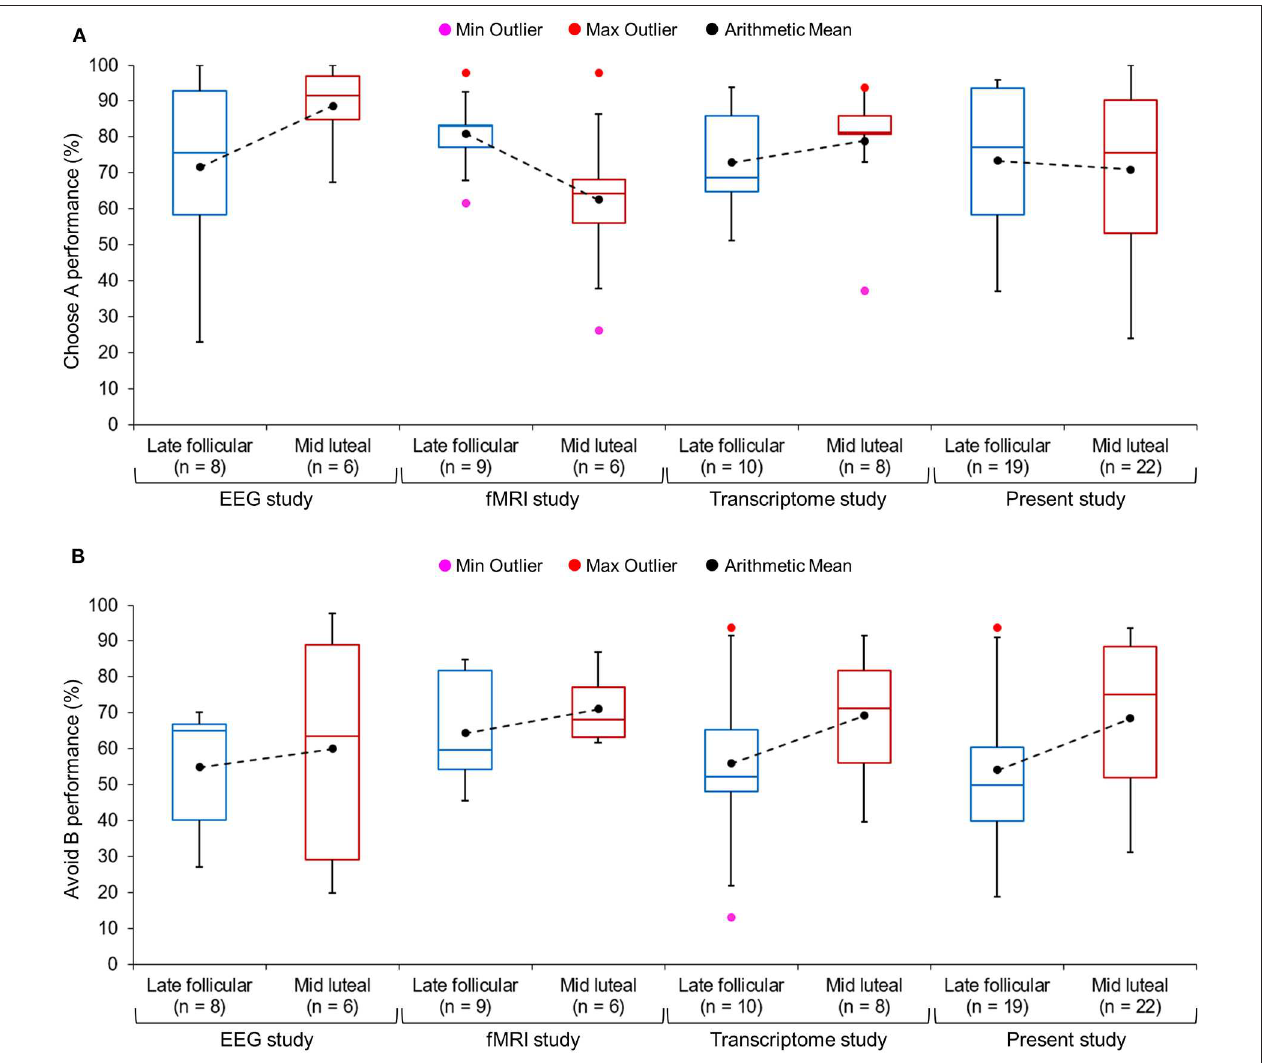
FIGURE 3 | Boxplots of the percentage of (A) correct choice of the best stimulus A, and of (B) correct avoidance of the worst stimulus B in novel stimulus pairs presented during the transfer phase. The ends of the whisker are set at 1.5*interquartile-range above the third quartile and 1.5*interquartile-range below the first quartile. Only the minimum (Min Outlier) and maximum (Max Outlier) outliers are shown here. We also added the arithmetic mean of the percentage of correct selection for each study and cycle phase to the box plot (see black dots; mean values from the same study are connected by a dashed line). The figure was created with the box plot template by Wittwer